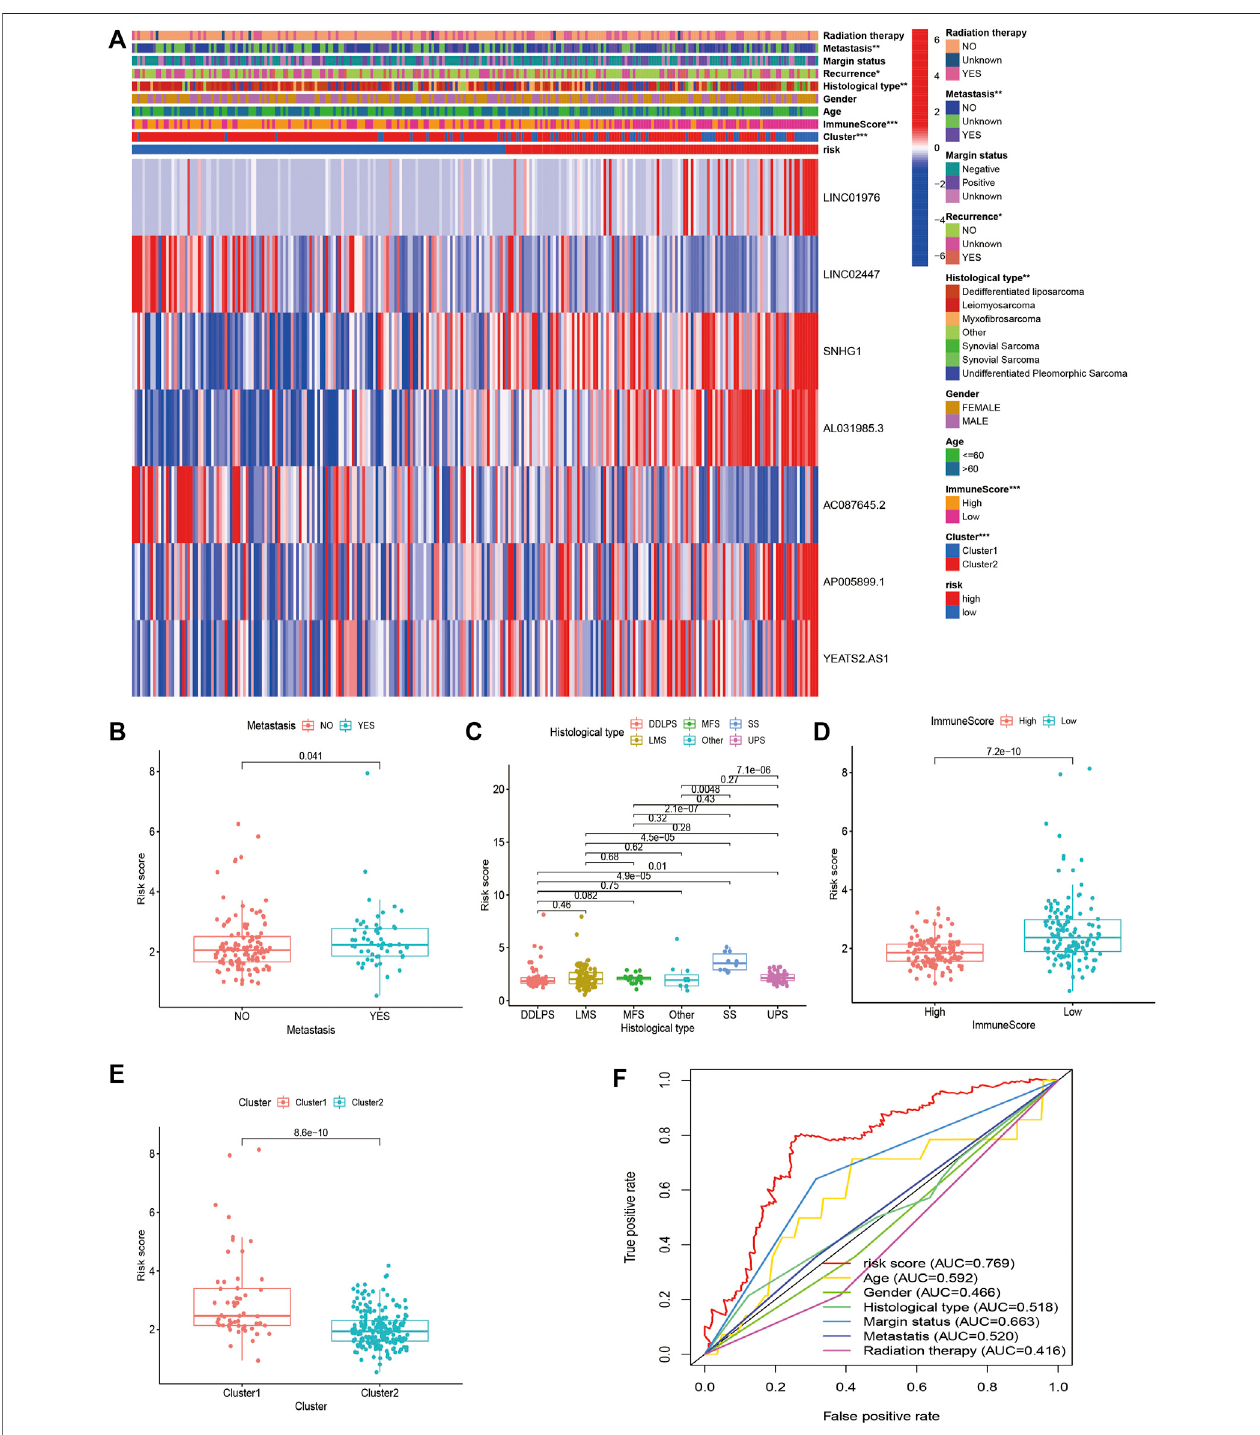
FIGURE 8 | Clinical Evaluation of m6A-Related lncRNAs-Based Risk Signature in STS. (A) The heatmap of the associations between the risk score and clinicopathological features. (B – E) The boxplots of the associations between the risk score and (B) metastasis, (C) histological type, (D) immune score, and (E) cluster. (F) A comparison of 5-year ROC curve with other clinical characteristics.